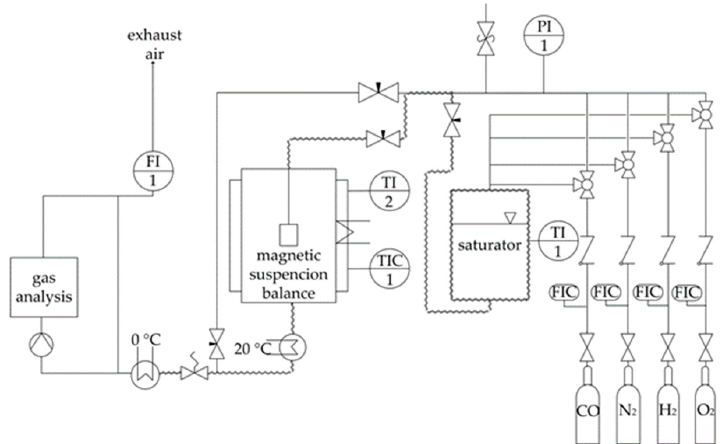
Figure 8. Setup of the magnetic suspension balance.